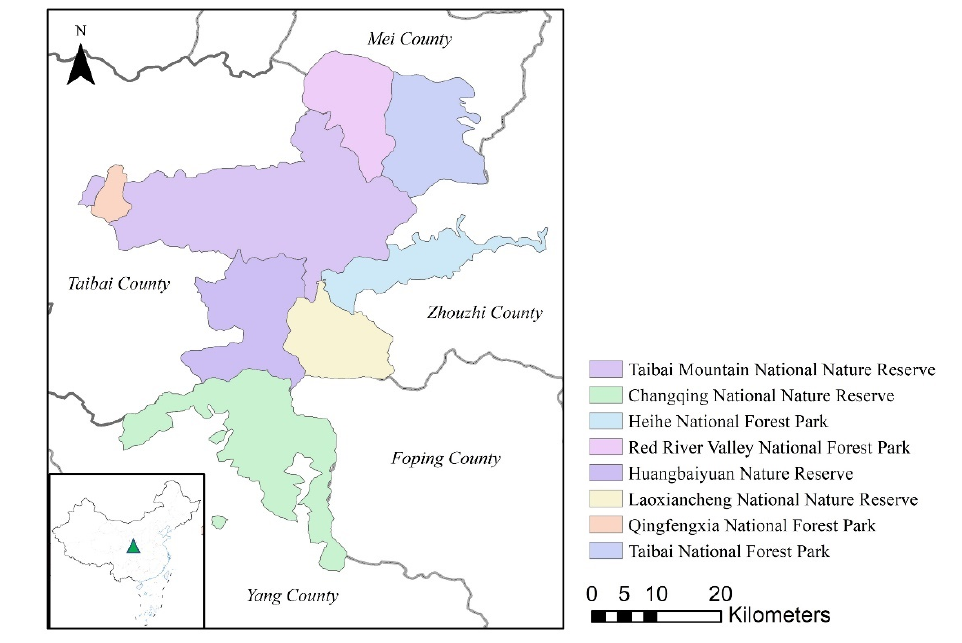
Figure 2. Study area.